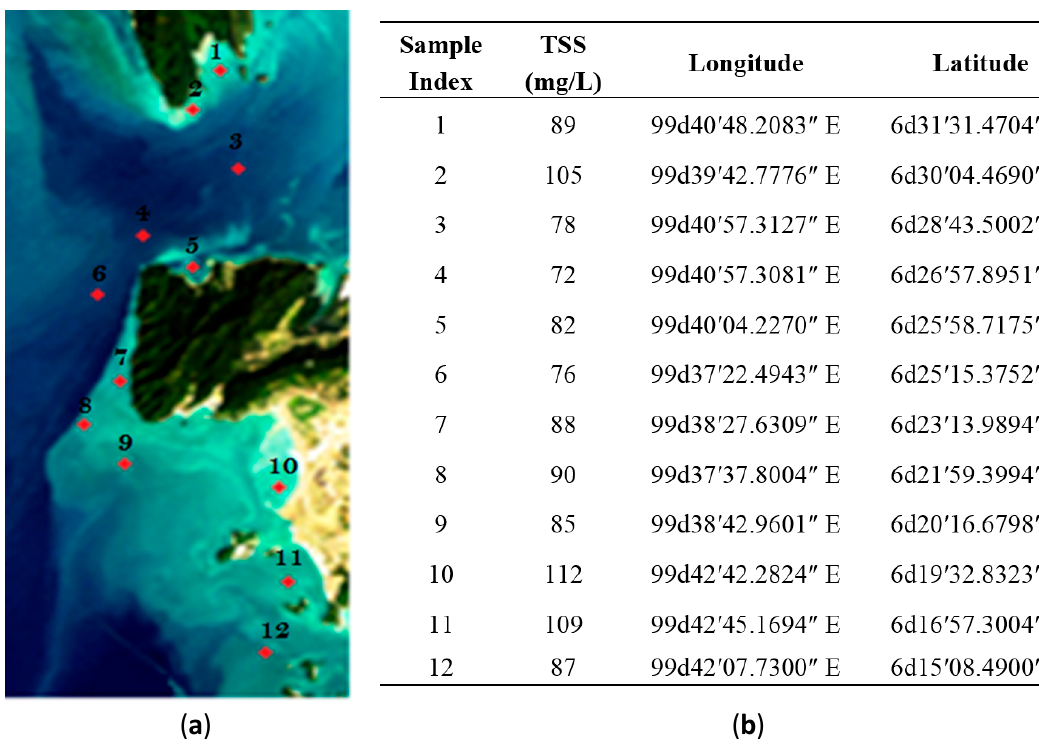
Figure 1. ALOS image of study area and validation data: ( a ) Raw satellite image and sampling indices; ( b ) Samples locations and their concentrations values.